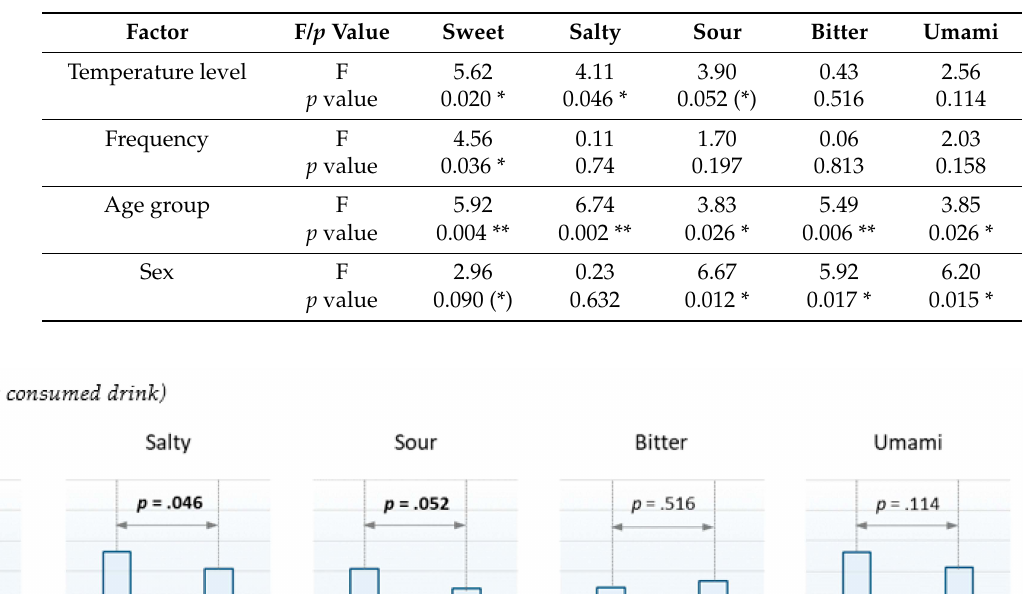
Table 3. Summary of the ANCOVA (type III) carried out (one analysis by taste). Model: score = age group + sex + temperature level + frequency. p values smaller than 0.1 are in bold. p values: (*) p <